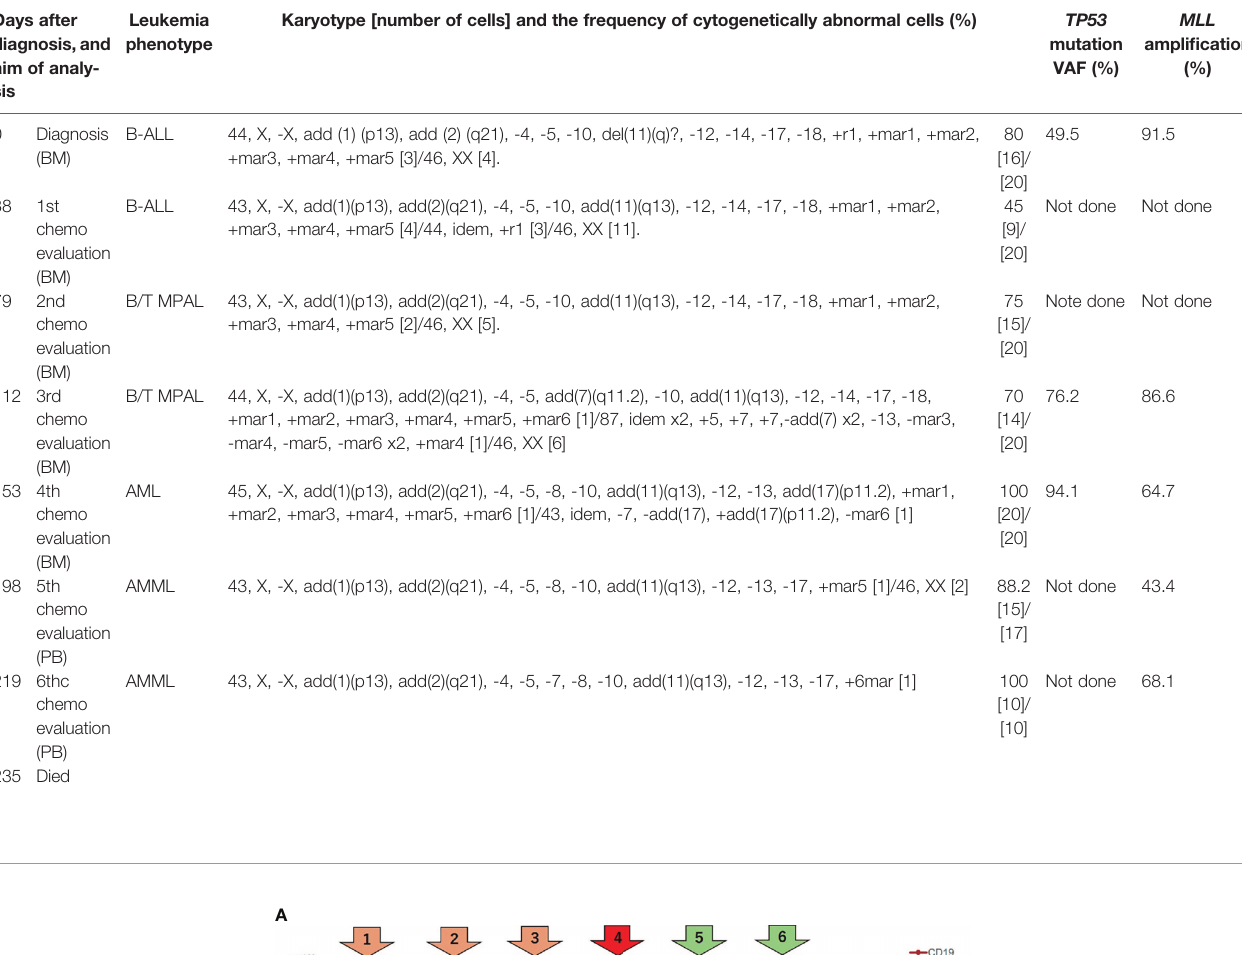
TABLE 1 | Changes in karyotype and TP53 mutation frequency of the present case. Days after diagnosis,and